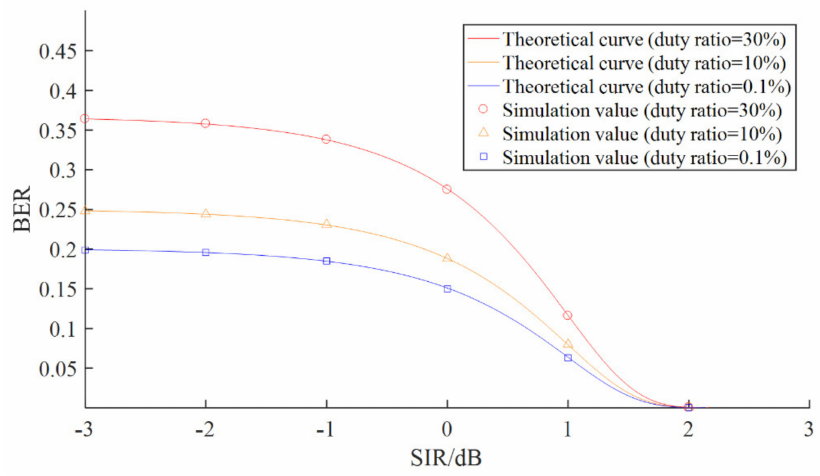
Figure 10. Variation curve of receiver BER with SIR under pulse signal interference (linear